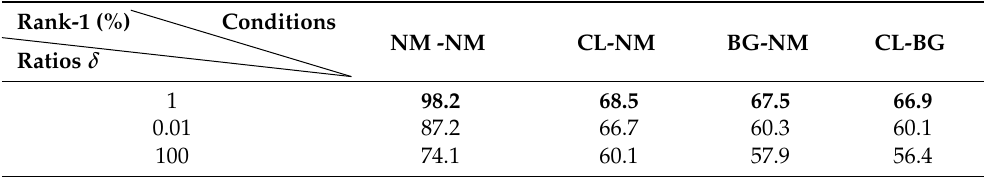
Table 2. Rank-1 matching accuracy (%) comparisons among different ratios δ between balanced coefficients of the total loss function. We trained the proposed model under the supervision of different ratios δ and tested the trained models on single and cross conditions.